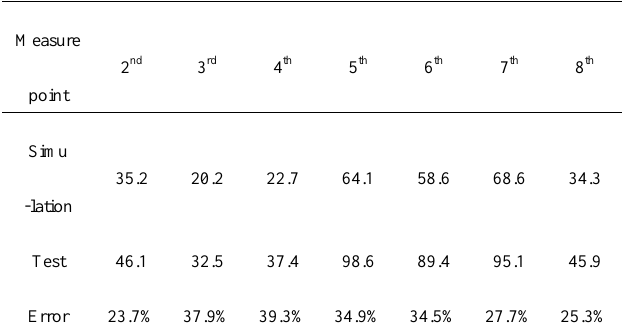
Table 3. Root mean square values of normal vibration